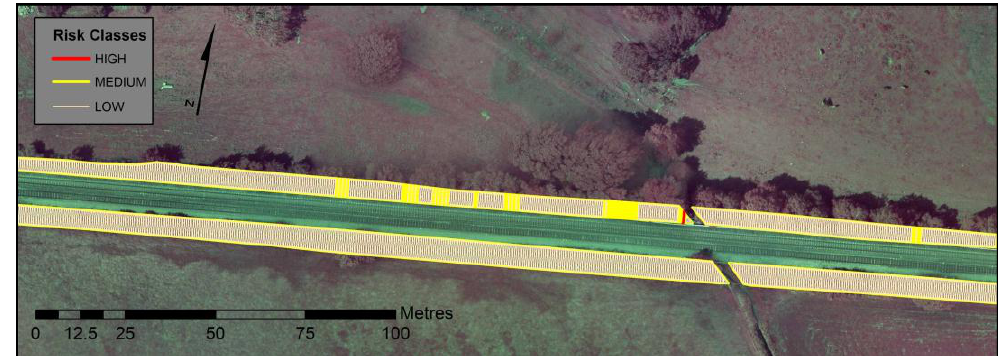
Figure 3. Cross-section risk classification for section of test